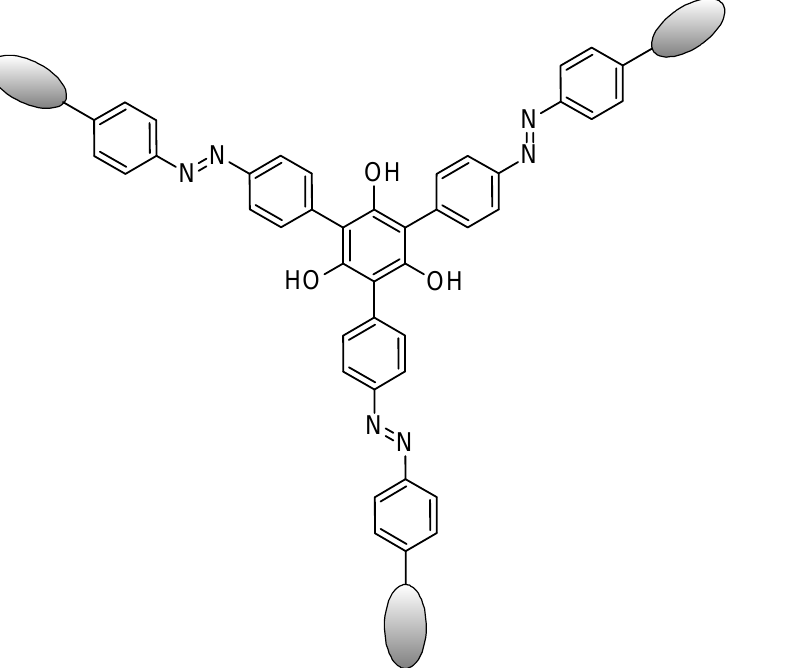
Figure 11. Schematic representation of phlorocello. The elliptic drawings represents the cellobiosic moieties.